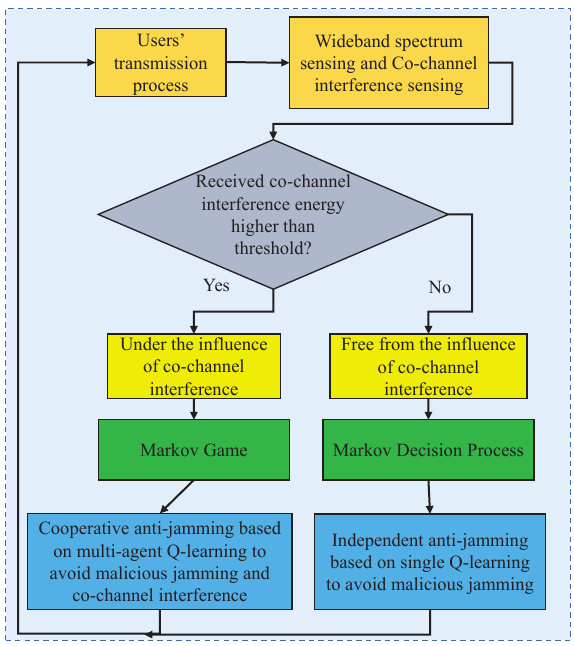
Figure 2. Interference-aware cooperative anti-jamming mechanism in the UAV